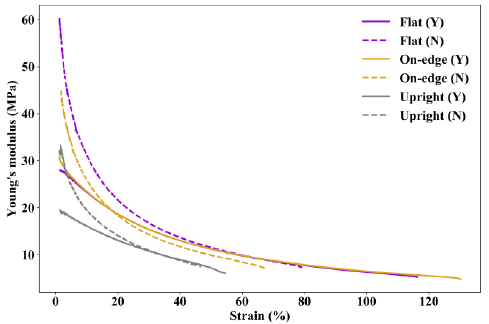
Figure 14. Comparison of the moduli at different strains of specimens. “Y” indicates specimens with post-processing, and ”N” means specimens without post-processing.